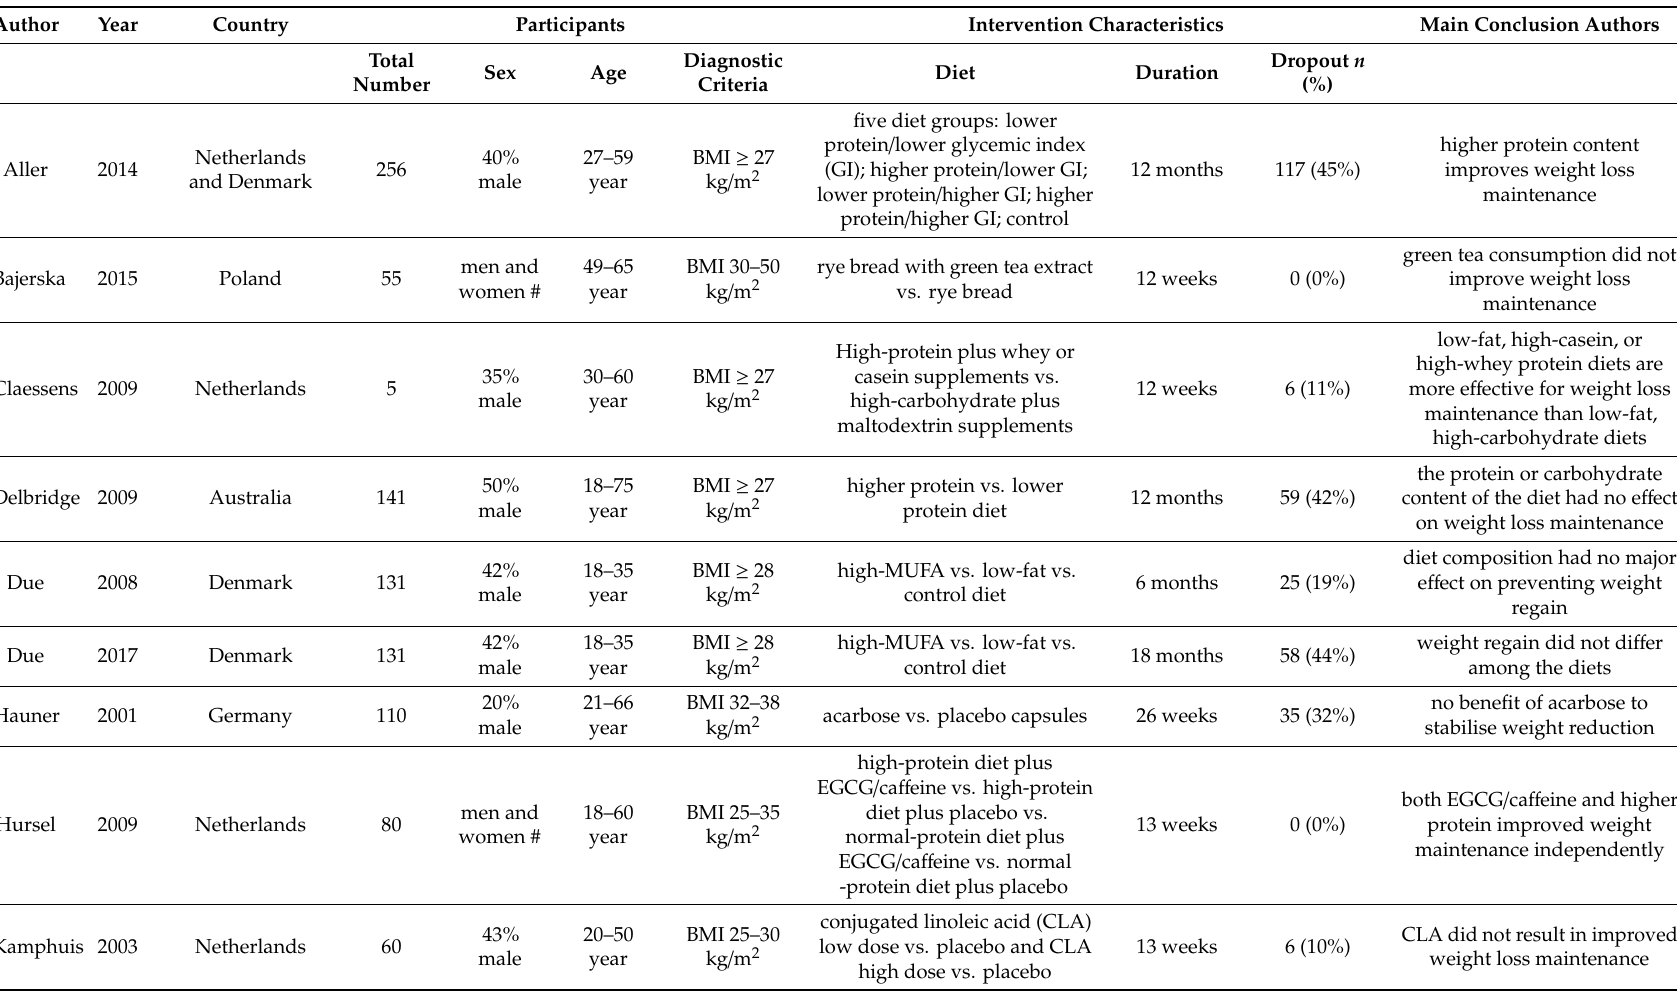
Table 1. Characteristics of the randomized clinical trials evaluating the e ff ect of dietary strategies on weight loss maintenance that have been included in the systematic